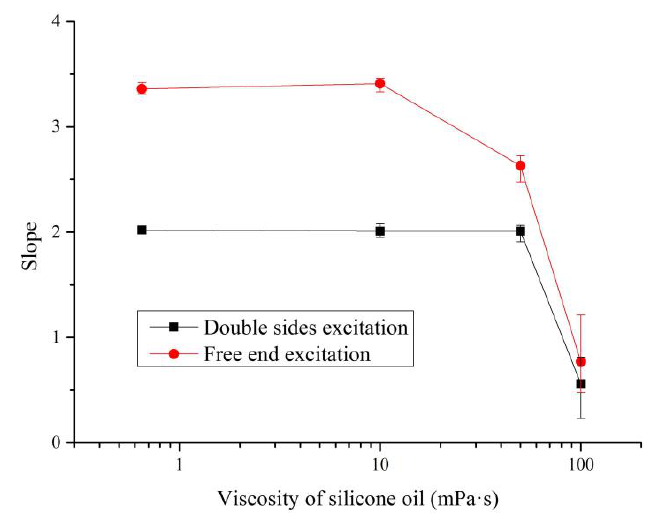
Figure 9. The effect of viscosity on the slope.